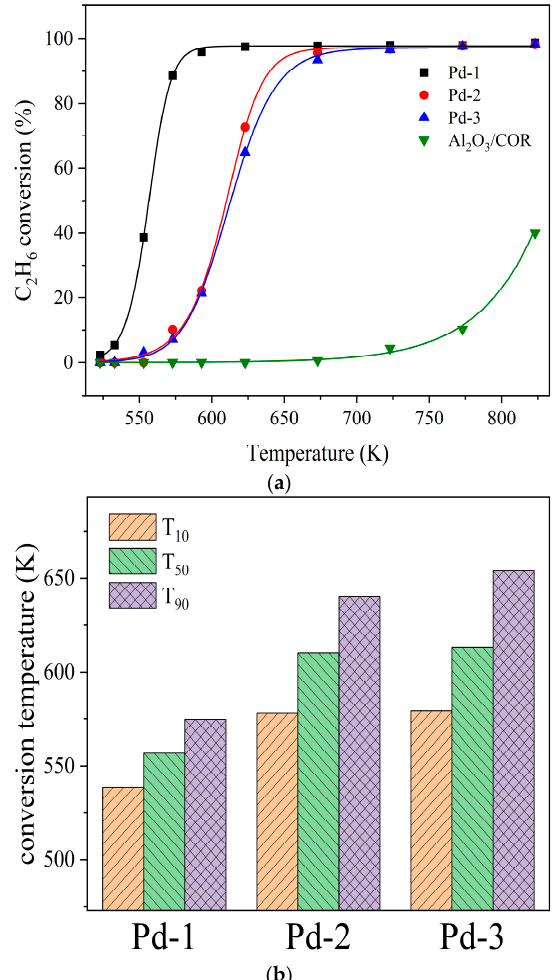
Figure 8. ( a ) Catalytic activity of Pd-1, Pd-2, Pd-3 and γ -Al 2 O 3 /COR for ethane. ( b ) T 10 , T 50 and T 90 of Pd-1, Pd-2 and Pd-3.